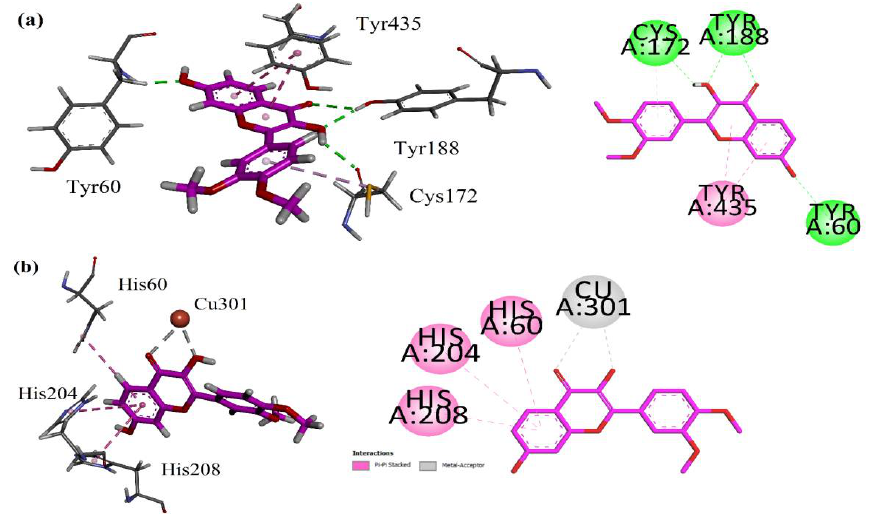
Figure 6. 3-D/2D interaction plots of compound in the binding sites of ( a ) MAO-B (PDB 2V5Z) and ( b ) tyrosinase (PDB ID = 5I38).